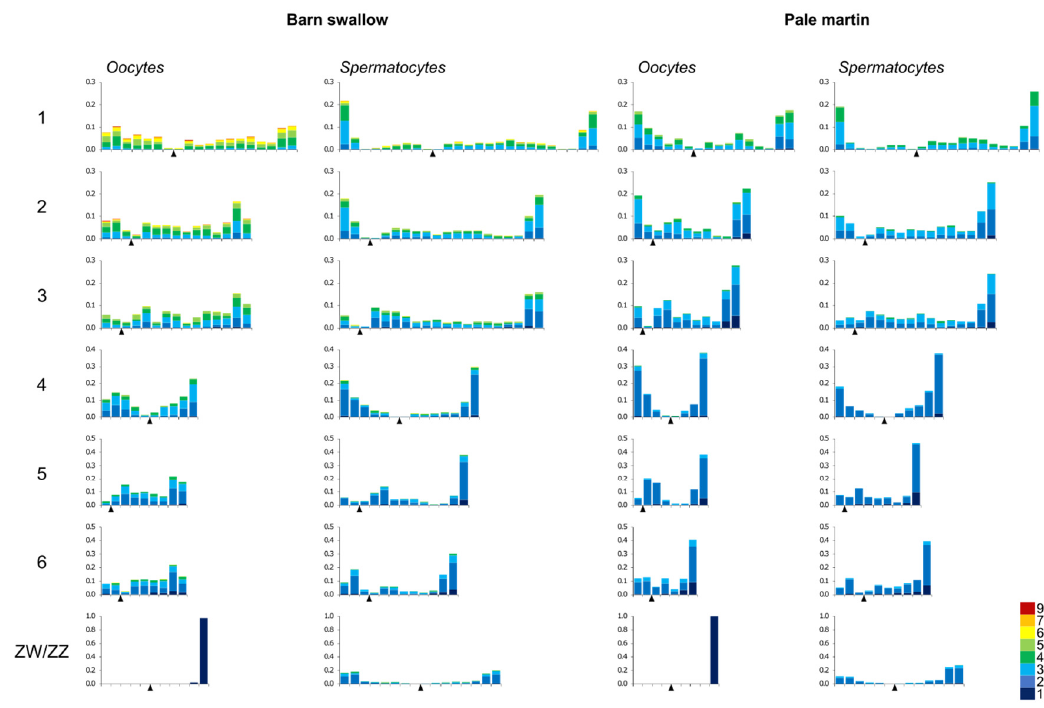
Figure 2. Distribution of MLH1 foci along individual SCs in pachytene oocytes and spermatocytes of barn swallow and pale martin. On the x -axis: the relative position of MLH1 foci at the six largest macroSCs and ZW / ZZ bivalents in relation to the centromere (black triangle). The width of the interval is approximately 1 µ m. On the y -axis: the proportion of MLH1 focus number in each interval. Colors indicate bivalents with 1–5 MLH1 foci per bivalent. The scale shows the color codes. The numbers to the left of the y -axis stand for chromosome numbers.